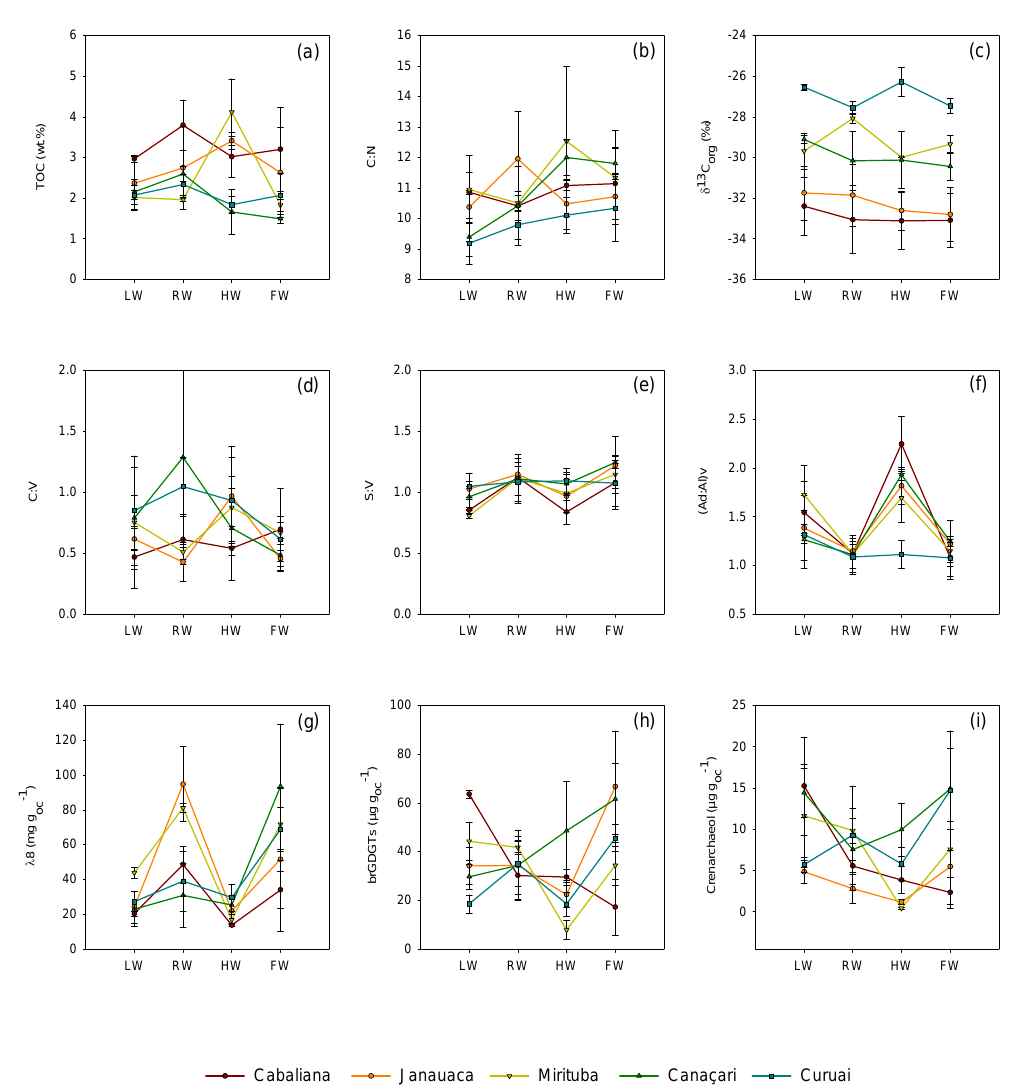
Figure 4. Box plots of total lignin phenols ( λ 8), and GDGTs for four hydrological seasons. The midpoint of a box plot is the mean. The 25 and 75% quartiles define the hinges (end of the boxes), and the difference between the hinges is the spread. Letters indicate statistically significant groups of data ( p